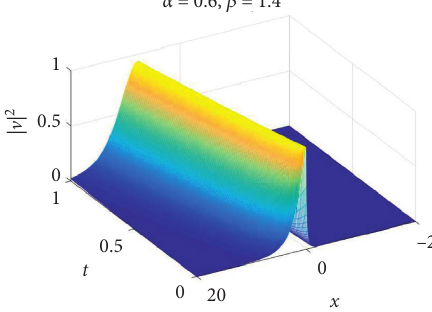
Figure 4: The trace of the solution to | v | 2 of FCNLSE (32) with α � 0 . 8 and β � 1 . 6.